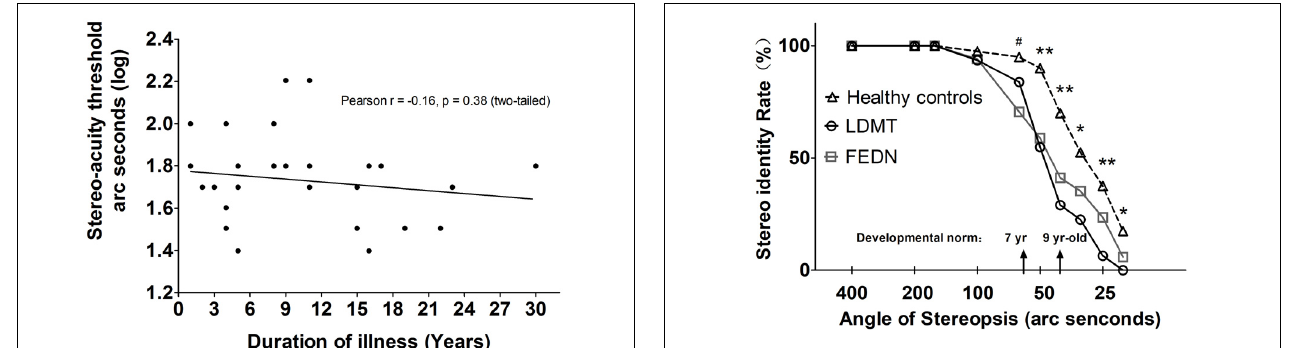
FIGURE 3 | Stereopsis detection at indicated angles of stereopsis for FEDN, LDMT and healthy control groups. Smaller angle of stereopsis correspond to increased task difficulty. ∗ Indicates difference between healthy controls and LDMT P < 0.05; ∗∗ Indicates difference between healthy controls and LDMT P < 0.01; # Indicates difference between healthy controls and FEDN P <